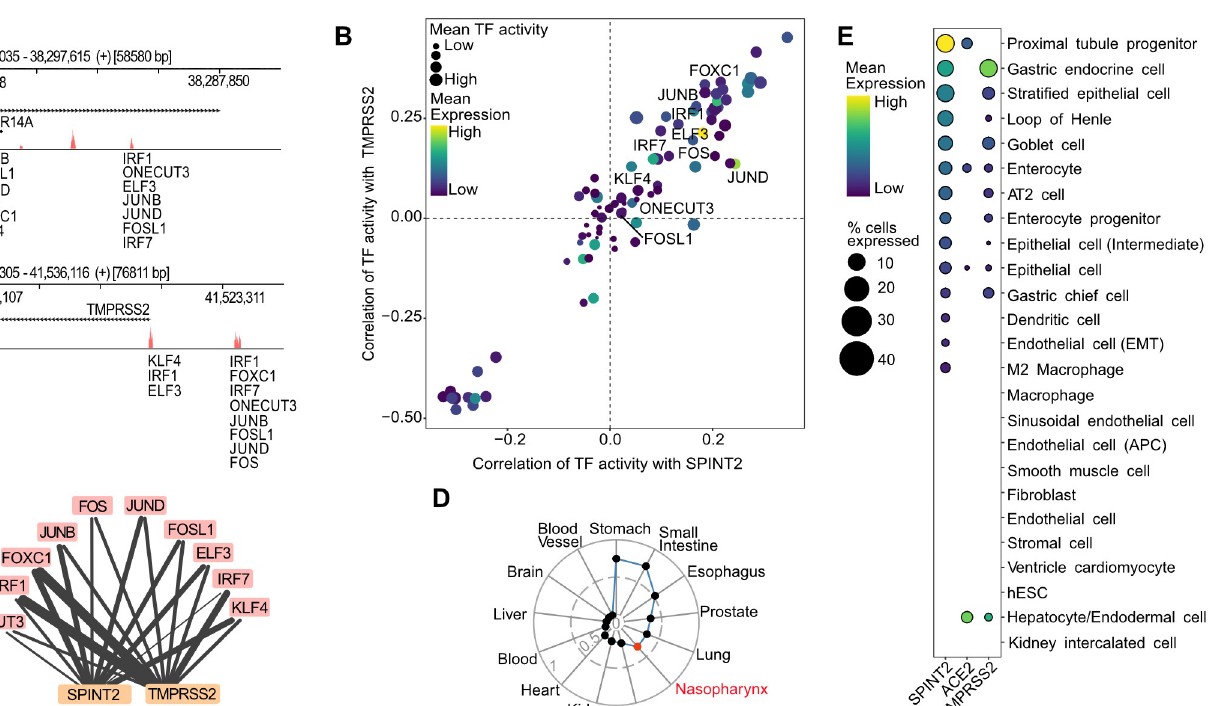
PLOS Pathogens| https://doi.org/10.1371/journal.ppat.1009687 June 28,